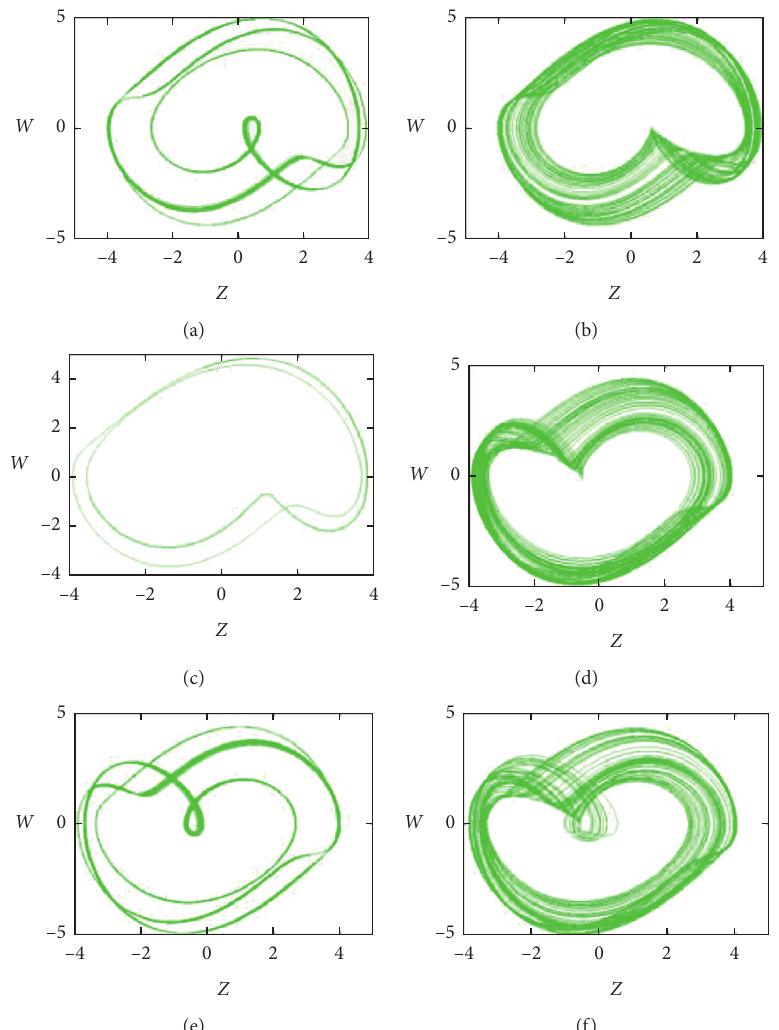
Figure 12: Typical coexisting attractors of system (1) with (a) � 0.8, (b) � 0.5, (c) � 1, (d) � 0.1 and initial condition IC � ( x � − 0.0874, (b) x